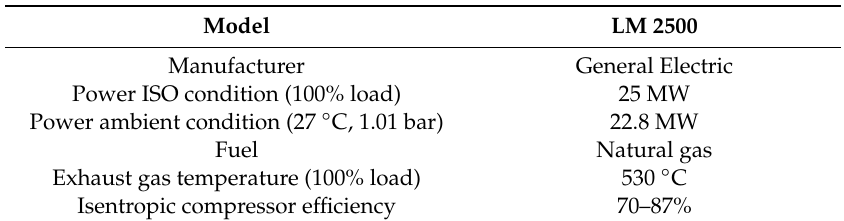
Table 5. Gas turbine specifications